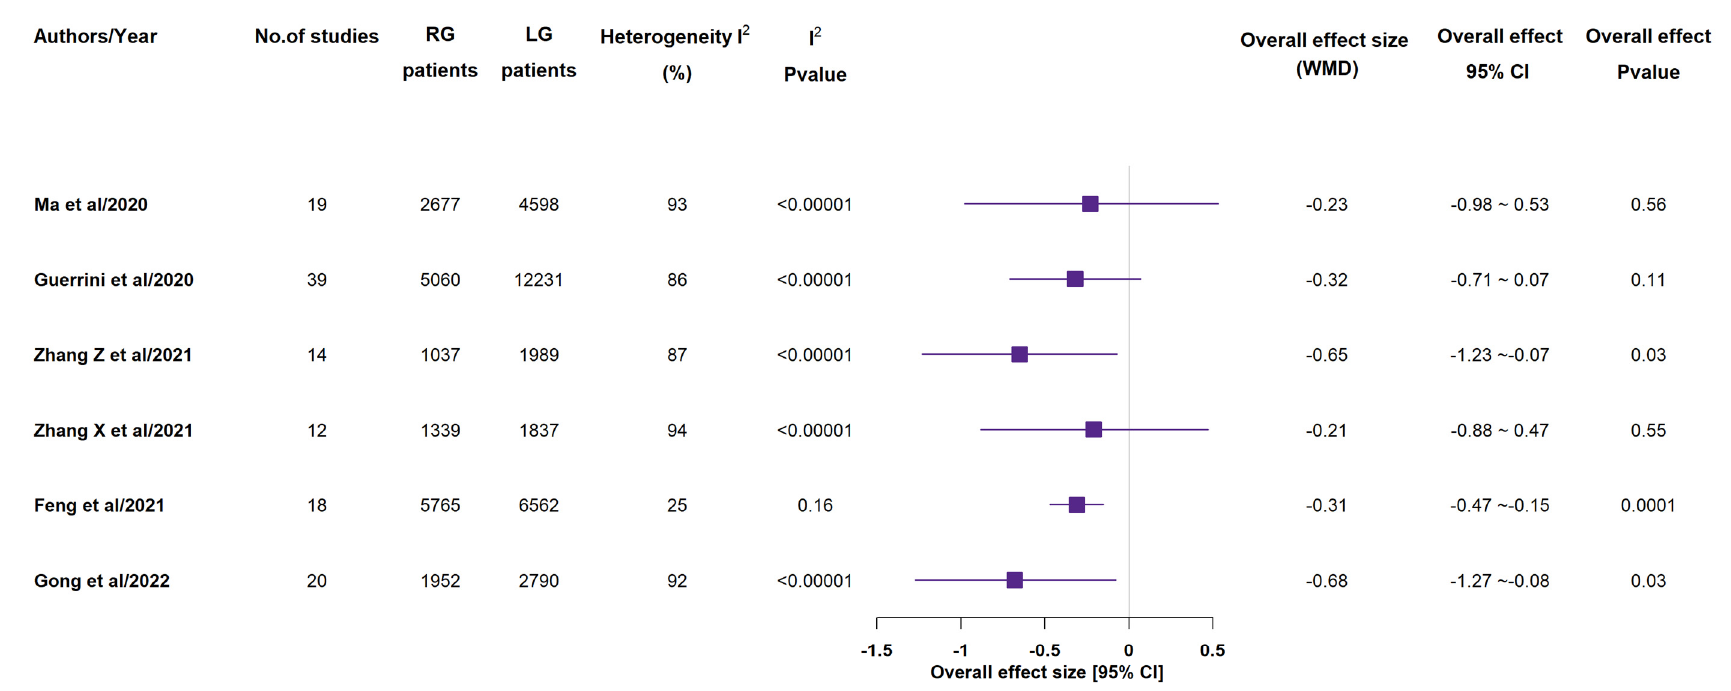
Figure 7. Length of hospital stay (days). RG = Robotic gastrectomy; LG = Laparoscopic gastrectomy; WMD = weighted mean difference